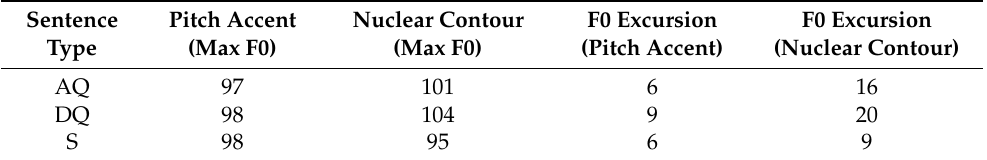
Table 3. Acoustic analysis of the perception (SI and IO tasks) and production stimuli (SI task). Mean max F0 values in the first pitch accent and the nuclear contour, and F0 excursion in the first pitch accent and nuclear contour (values in semitones).